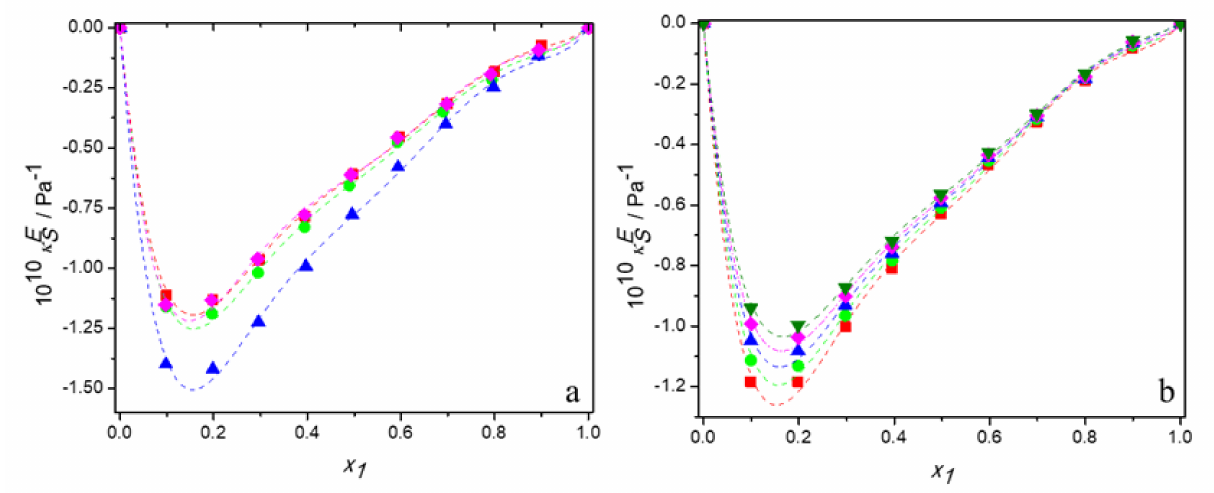
Figure 7. Dependence of the excess isentropic compressibility of aqueous solutions of DESs on molar fraction of deep eutectic solvent: ( a ) at 298.15 K for (cid:4) DES1; • DES2; (cid:78) DES3; (cid:7) DES4; ( b ) for DES1 at 298.15 K ( (cid:4) ); 298.15 K ( • ); 303.15 K ( (cid:78) ); 308.15 K ( (cid:7) ); 313.15 K ( (cid:72) ); —, Equation